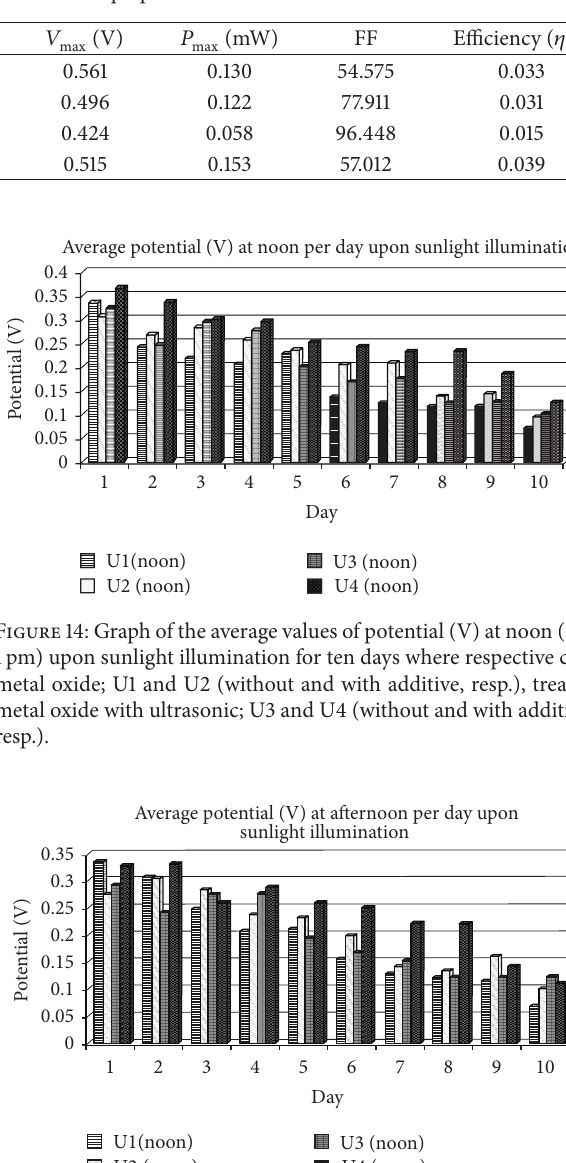
Table 2: The electrical characterization of all prepared cells.